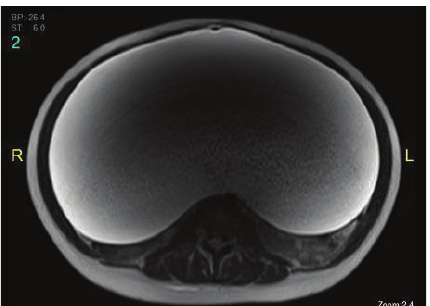
Figure 1: Abdominal ultrasound.